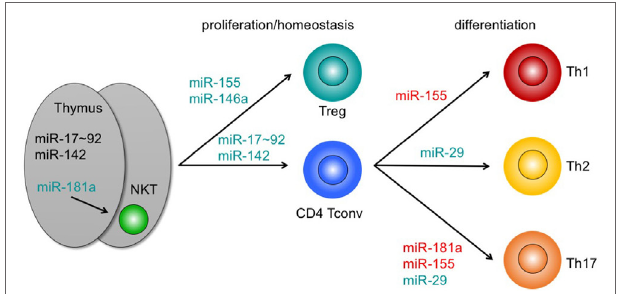
FiGURe 1 | Pathophysiologically relevant microRNAs (miRNAs) in graft- versus-host disease with a functional role in T-cell development, homeostasis, and differentiation. miRNAs adjacent to arrows indicate those miRNAs that positively contribute to intrathymic development (left), proliferation and/or homeostasis (center), or differentiation of T cell subsets. miRNAs highlighted in green mirror exert major functions. Loss of these miRNAs partially mirrors depletion of all miRNAs in mice. miRNAs highlighted in red indicate miRNAs with non-dominant functions. For details, see text. Abbreviations: NKT, natural killer T cell; Treg, regulatory T cell; Tconv, conventional T cell; Th, T helper